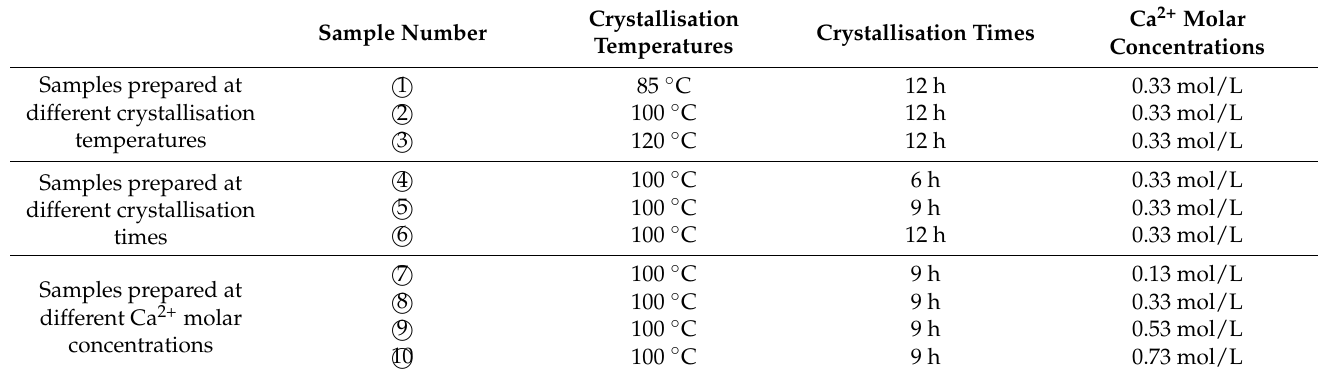
Table 1. Summary of experimental